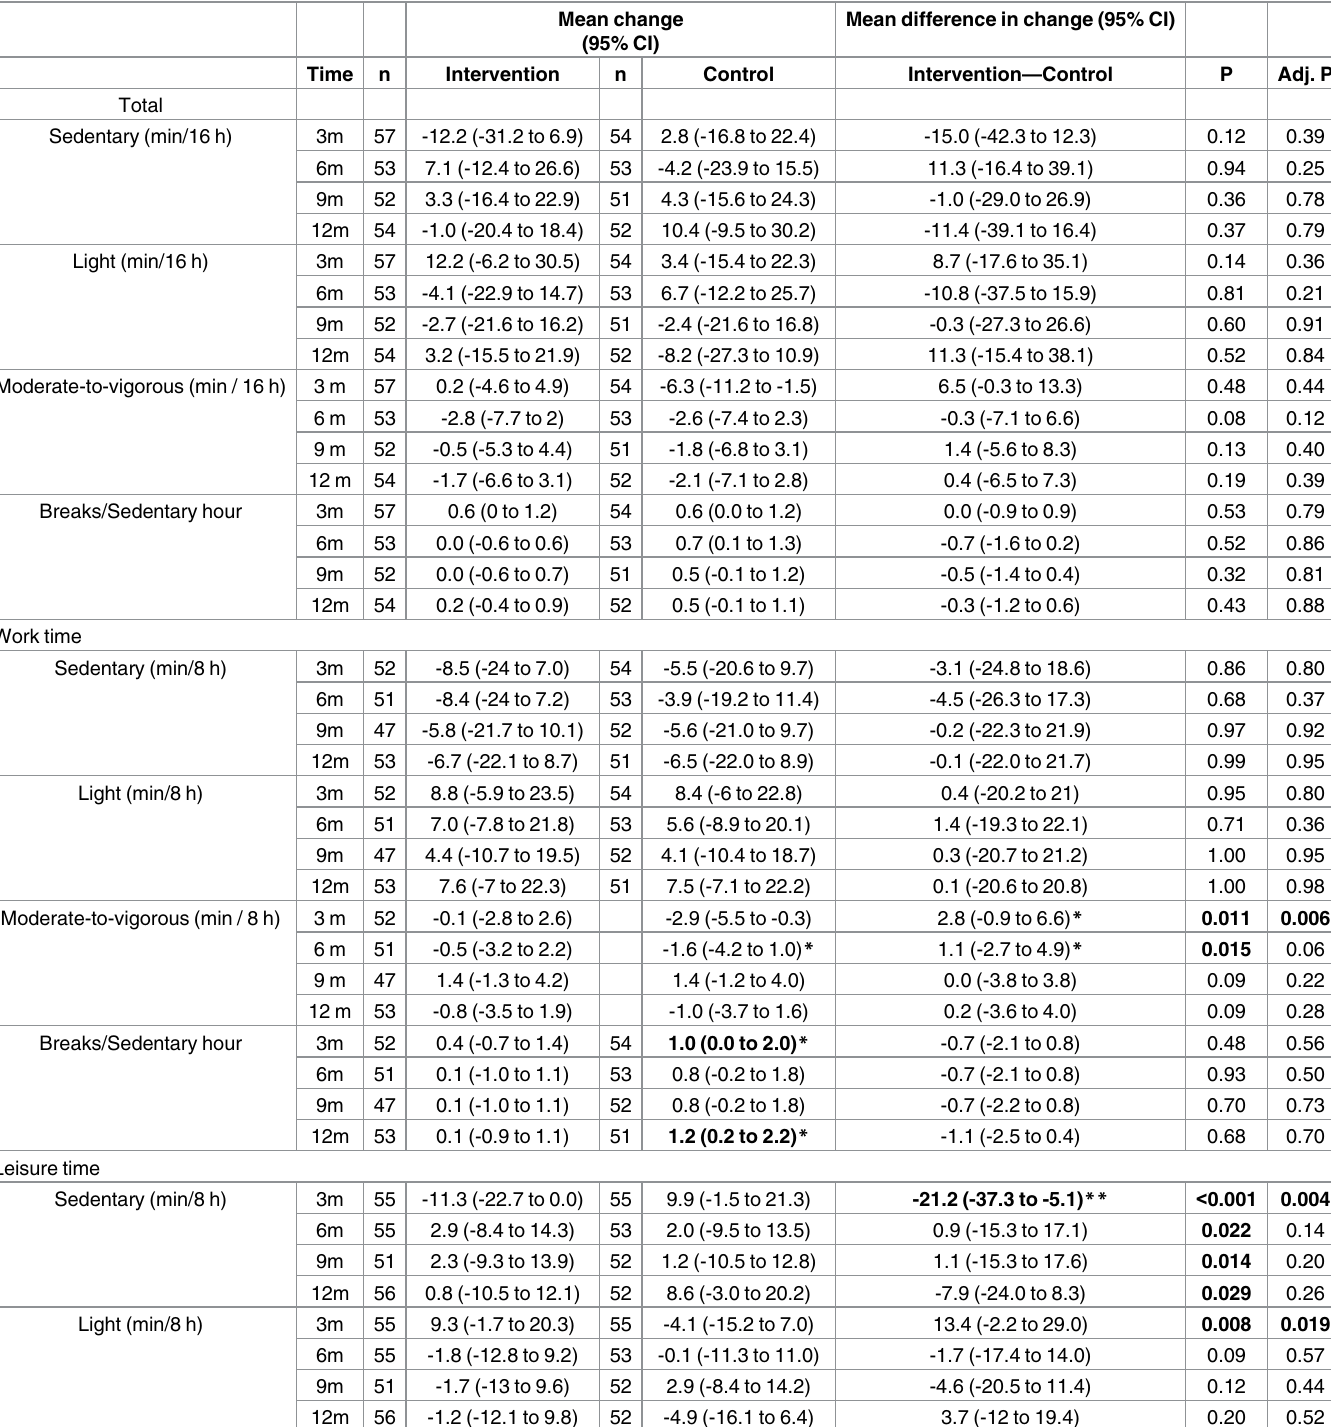
Table 2. Intervention effectiveness on primary outcomes in different domains as unadjusted estimated marginal means of change from baseline. Mean change Mean difference in change (95% CI) (95% CI) Time n Intervention n Control Intervention—Control P Adj. P Total